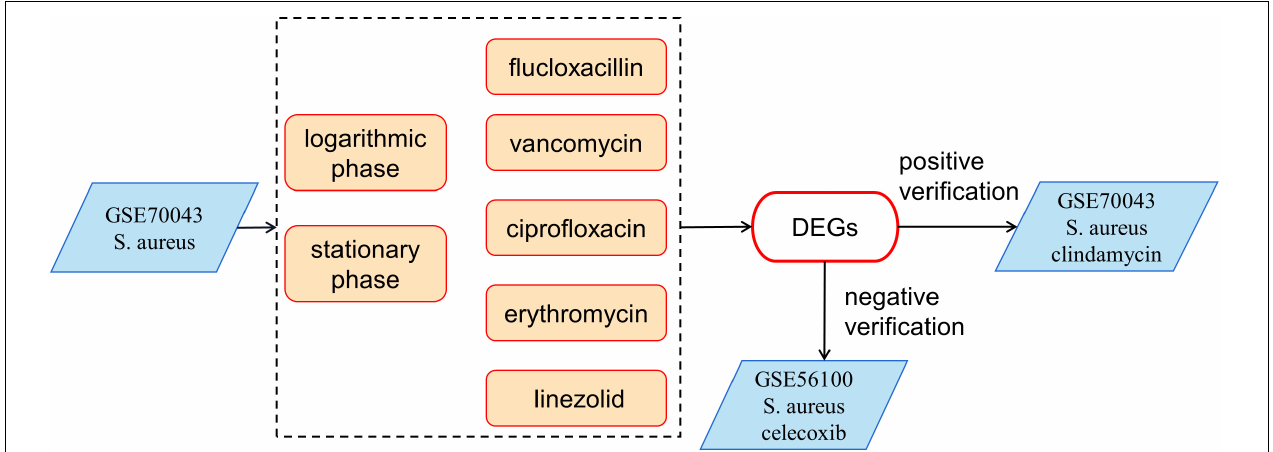
FIGURE 1 | The bioinformatics processes used in this study. The expression data of GSE70043 was used as modeling data. GSE56100 was used as a negative control and the clindamycin treated samples were used as positive controls.